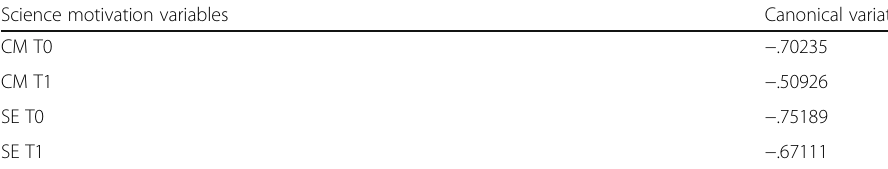
Table 4 Correlations between the raw SM variables and their canonical